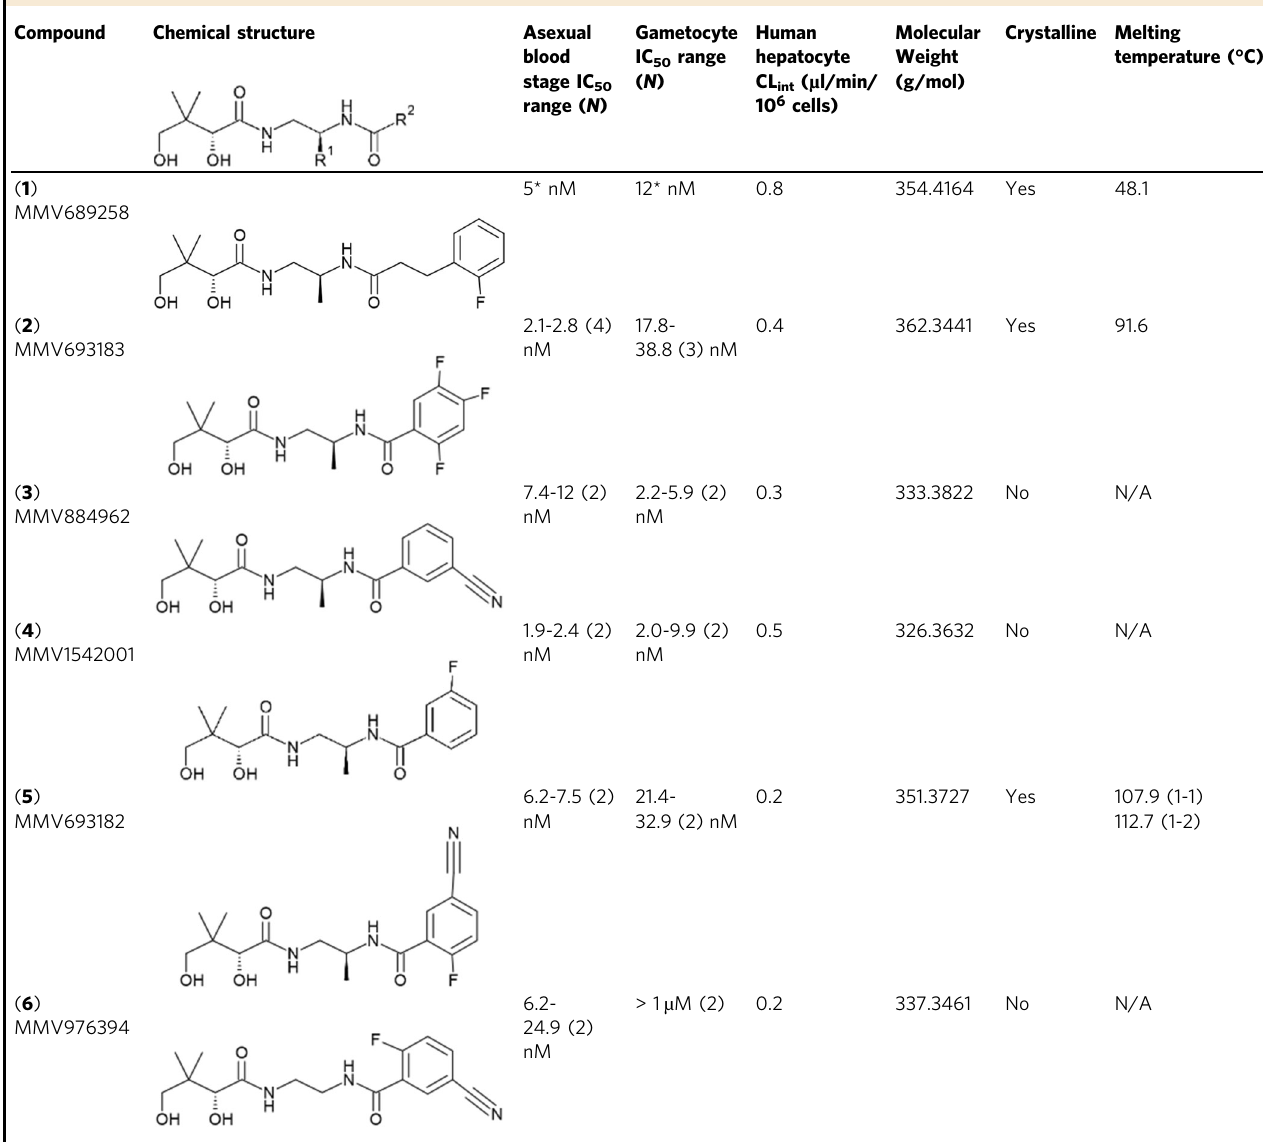
Table 1 Physicochemical characteristics and in vitro activities of pantothenamides.